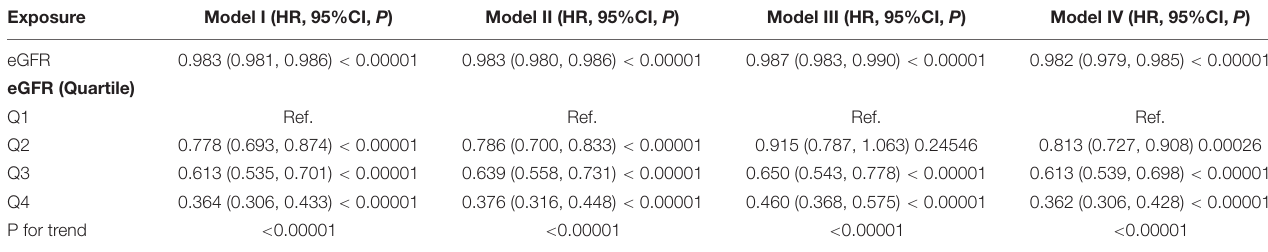
TABLE 5 | Relationship between eGFR and NAFLD in different sensitivity analyses.